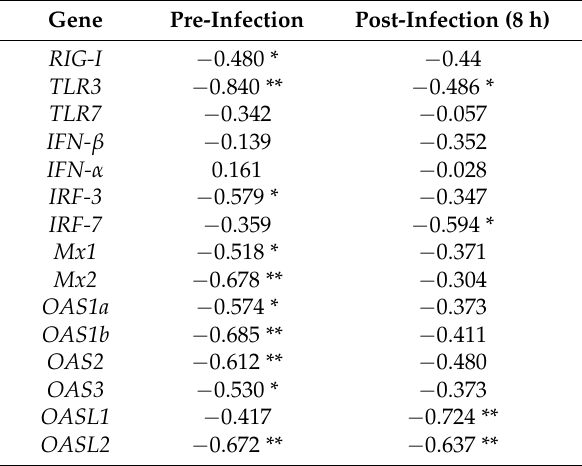
Table 1. The correlation coefficient (r s ) comparing the rNDV infection rate with type I interferon (IFN) related gene expression. Gene Pre-Infection Post-Infection (8 h) RIG-I − 0.480 * − 0.44 TLR3 − 0.840 ** − 0.486 * TLR7 − 0.342 − 0.057 IFN- β − 0.139 − 0.352 IFN- α 0.161